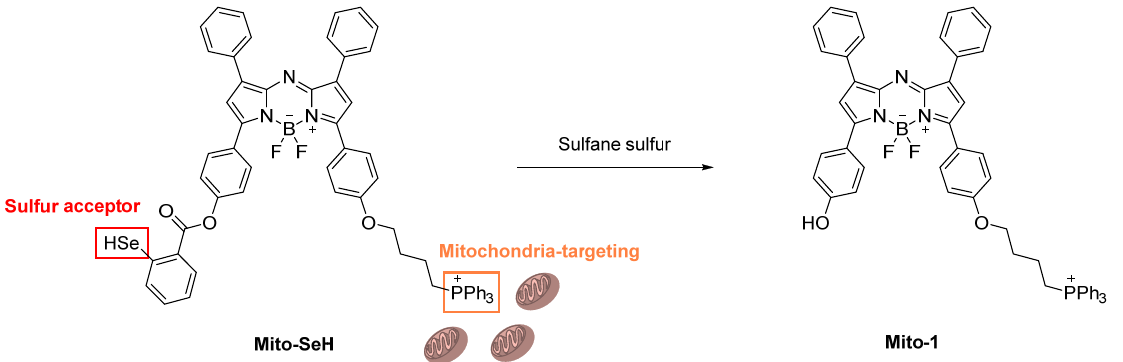
Figure 40. Probe design strategy for sulfane sulfur detection by Gao et al.